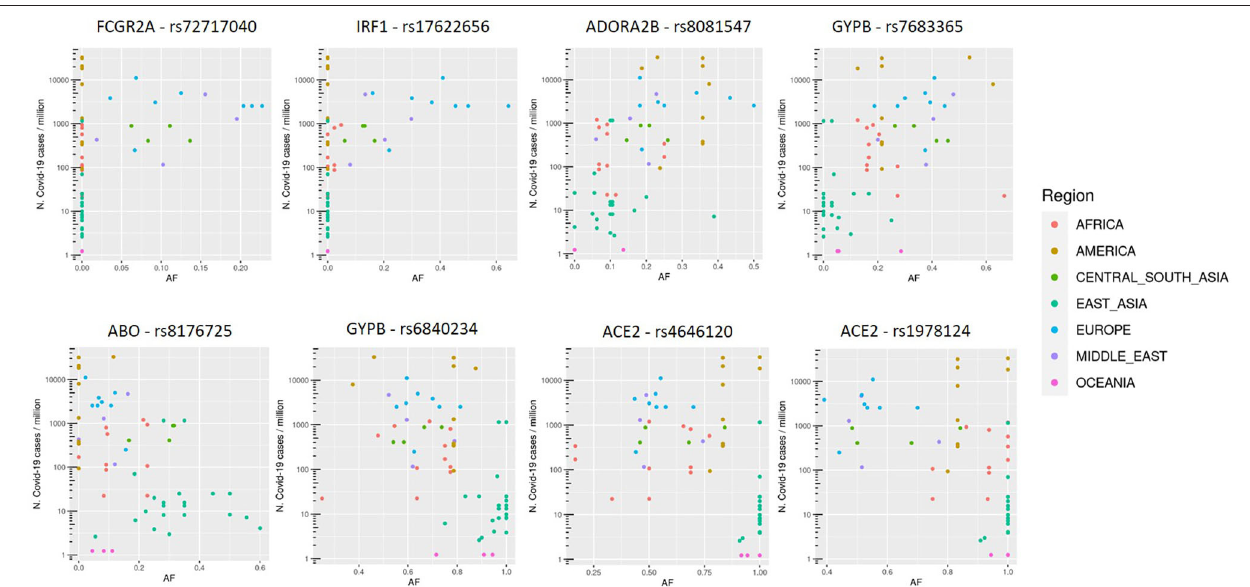
FIGURE 2 | Allele frequency (AF) distribution in each population of selected variants, named with the rs number and gene symbol, in relation to the COVID-19 prevalence (n. COVID-19 cases/10 6 inhabitants). Each dot is a population and colors are associated to specific geographic area, as reported in the